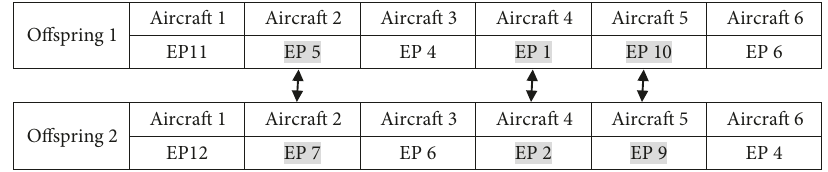
Figure 7: An example of uniform crossover